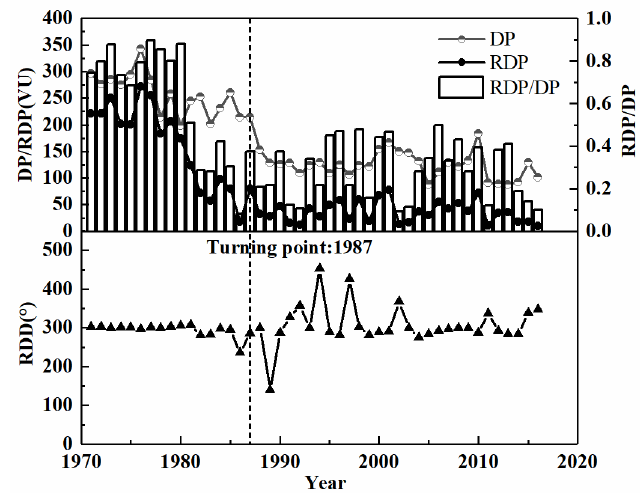
Figure 7. Change process of wind regime (DP, drift potential; RDP, resultant drift potential; RDD, resultant drift direction; RDP/DP, directional variability) before and after the turning point in the BJD.